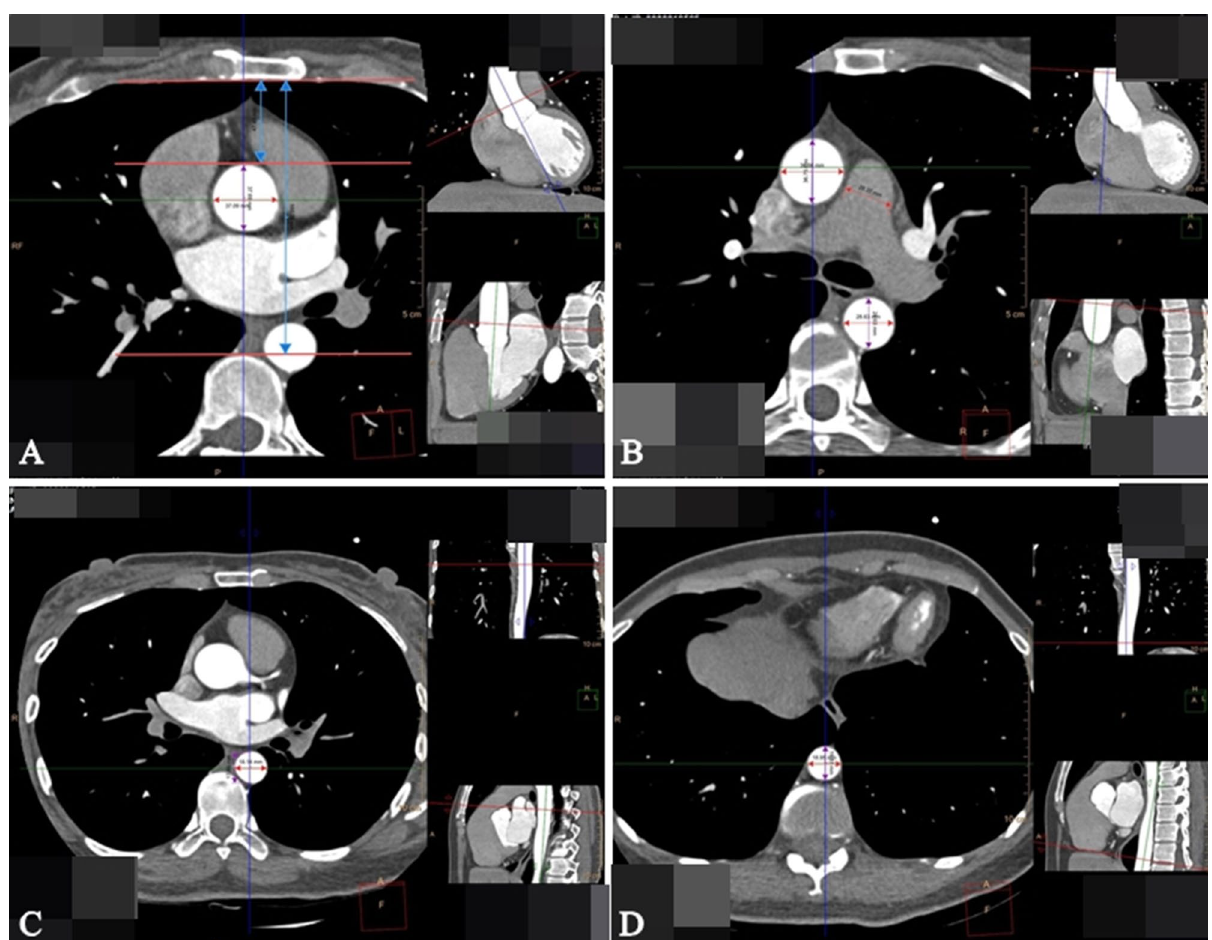
Figure 2. Axial contrast enhanced CT thorax with cardiac gated CT protocol were performed and representative slices were include at the levels of ( A ) The plane of sinus junction—the transverse and anteroposterior diameter of the ascending aorta, the distance from sternum to ascending aorta and to spinal distances. ( B ) The plane of pulmonary bifurcation—the transverse and anteroposterior diameter of the ascending aorta, descending aorta, and the diameter of the main pulmonary artery. ( C ) The plane of sinus junction—the transverse and anteroposterior diameter of descending aorta. ( D ) The plane of the diaphragm— the transverse and anteroposterior diameter of descending